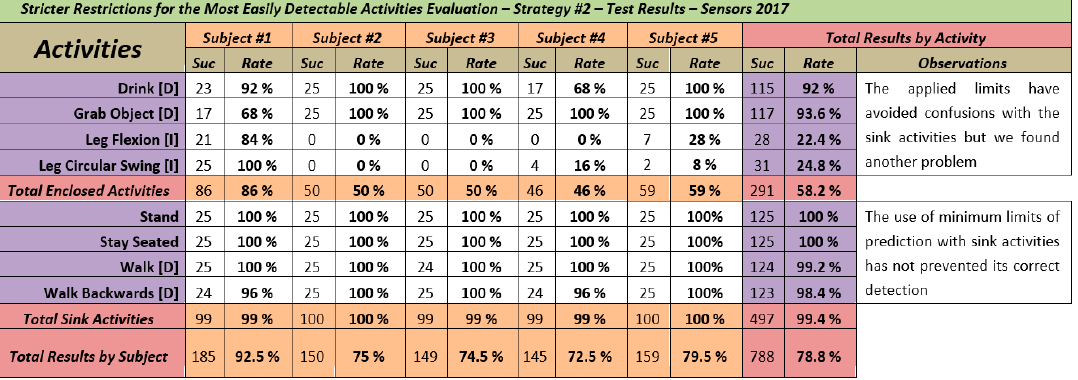
Figure 6. Stricter Restrictions for the Most Easily Detectable Activities Evaluation Results.